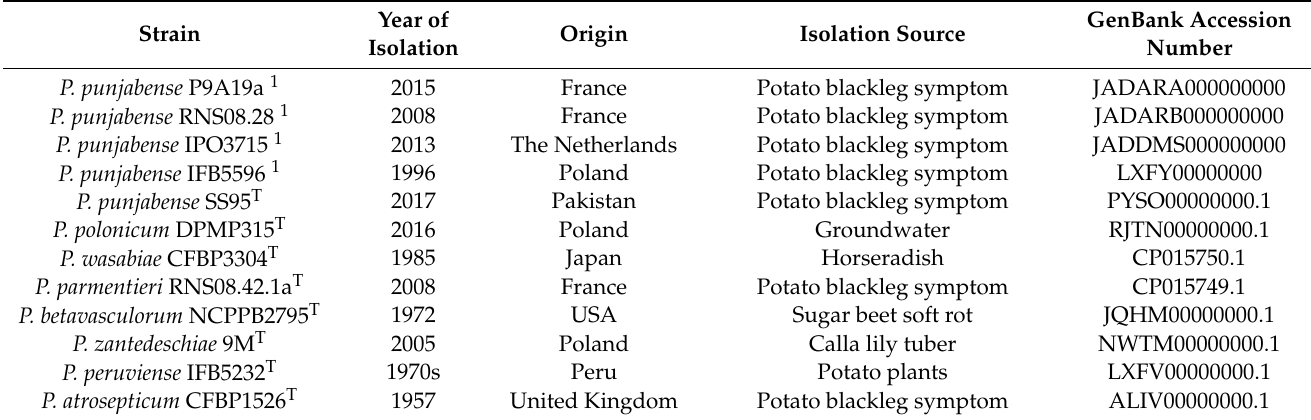
Table 1. P. punjabense strains selected for draft genome sequencing and additional representative Pectobacterium genomes used for genetic